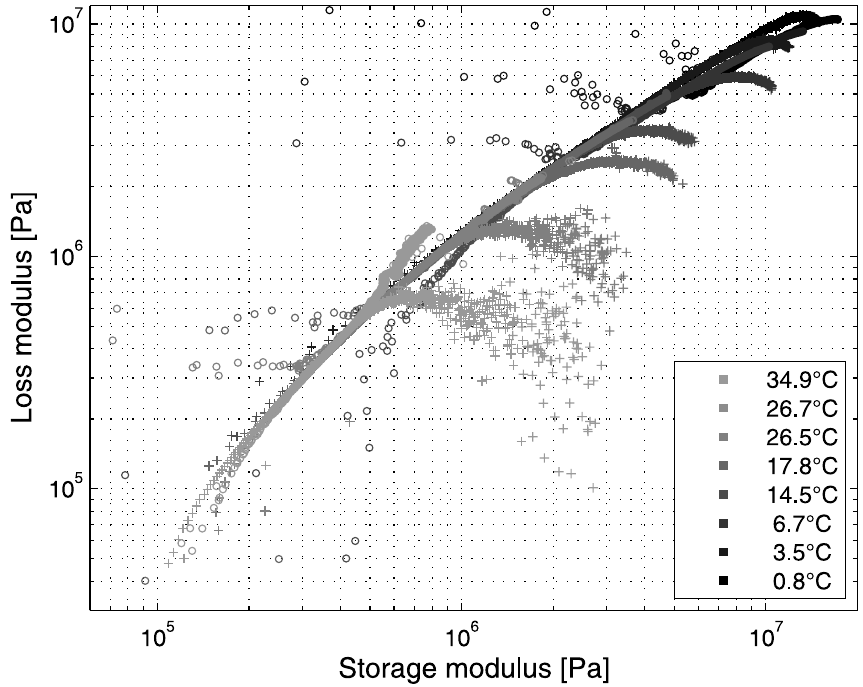
Fig. 4. Wicket plot of complex modulus data calculated from accelerance functions (circle) and receptance functions (plus